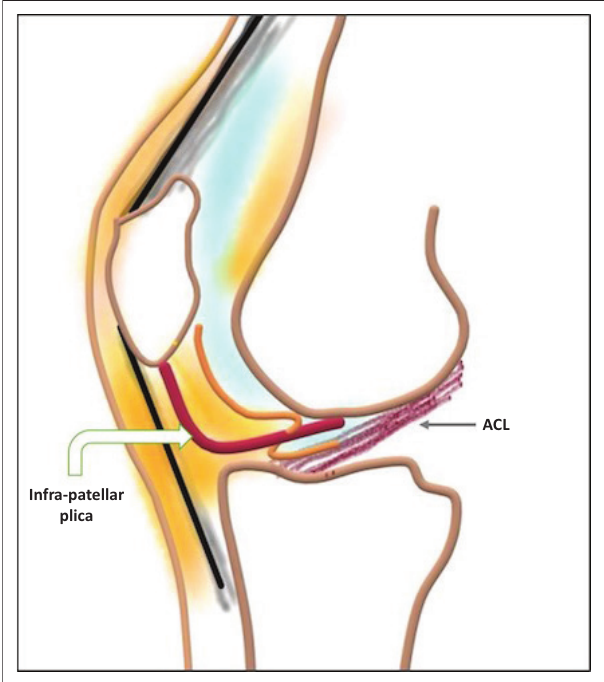
FIG URE 1: Schematic diagram of the anatomy of the infrapatellar plica and anterior cruciate ligament (ACL).